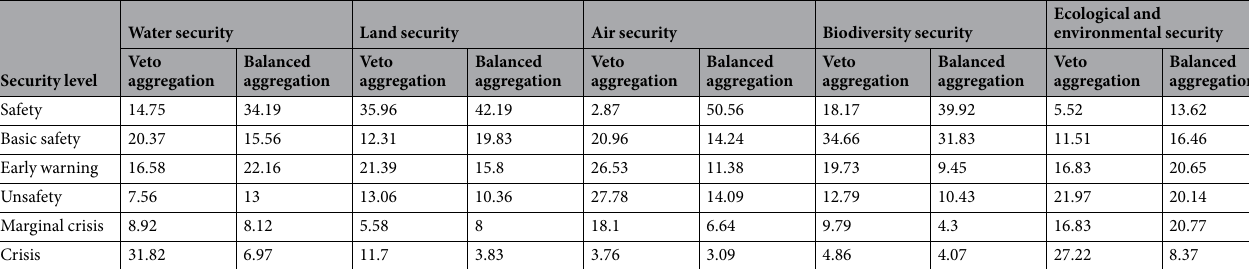
Table 1. Area proportion of ecological and environmental security level (%).